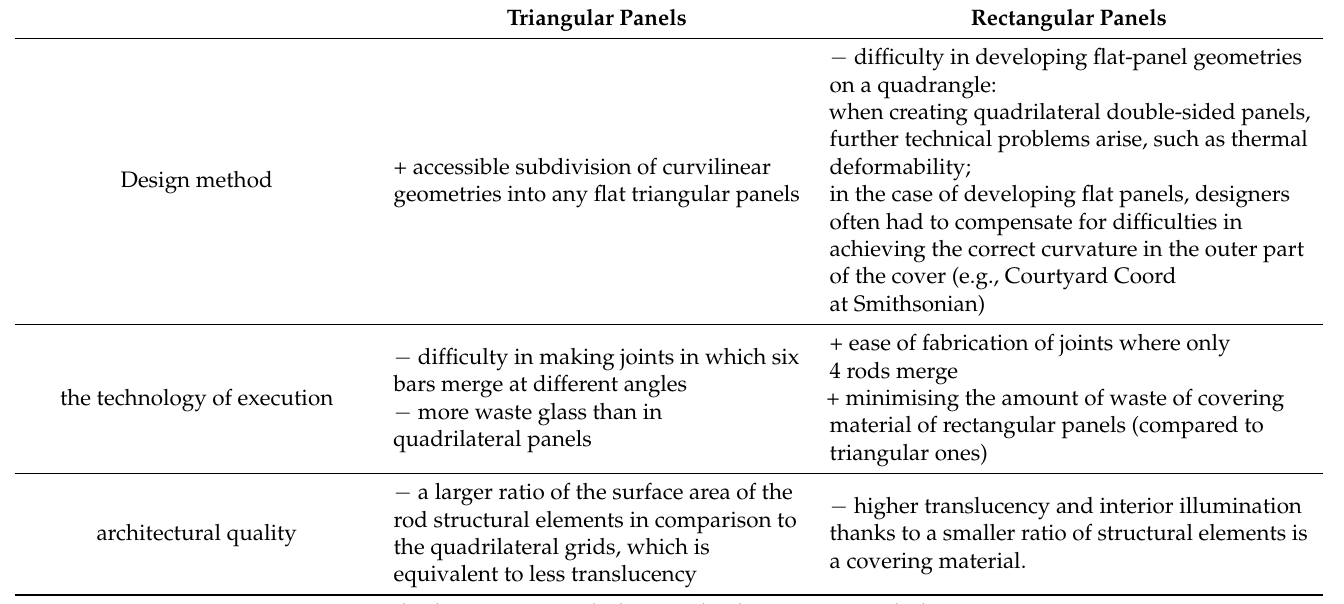
Table 1. A comparison of characteristics of free-form canopies in triangular and quadrilateral